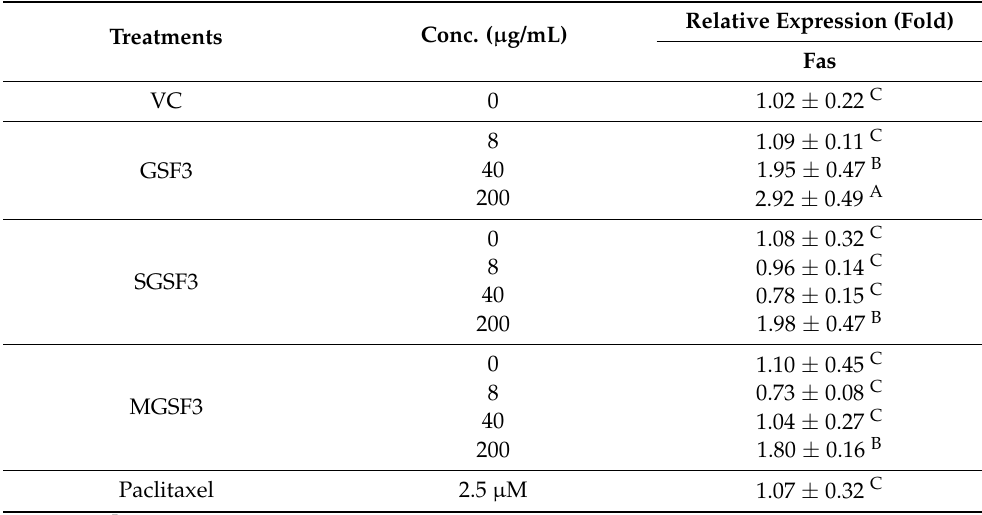
Table 2. Effects of GSF3 direct treatments and indirect immunotherapy using splenocyte